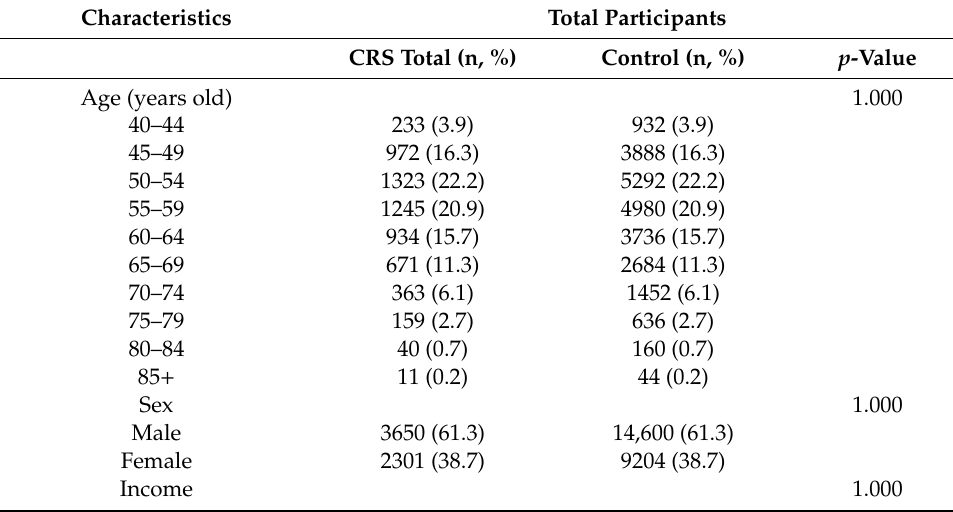
Table 1. General Characteristics of